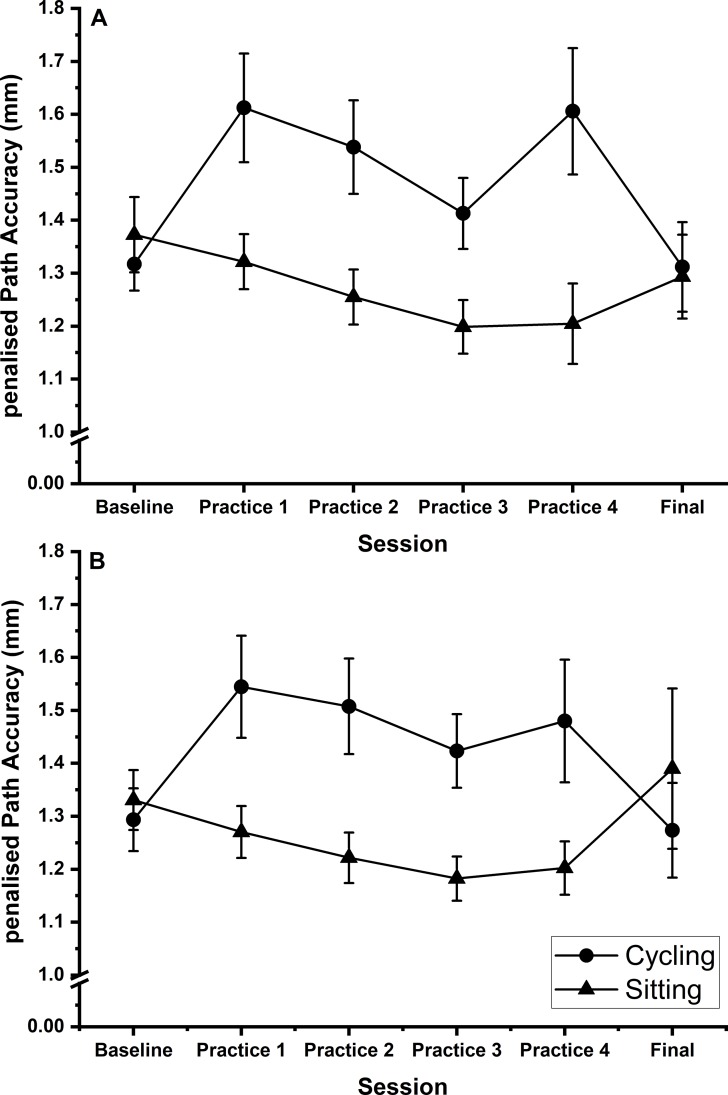
Steering.Shows line graph of mean penalised path accuracy (pPA) during the steering subtest across all sessions. Graph A (top) = shape A data, Graph B (bottom) = shape B. Circles represent the cycling group, triangles the sitting group. Smaller pPA values indicate greater accuracy. Error bars represent standard error of the mean.